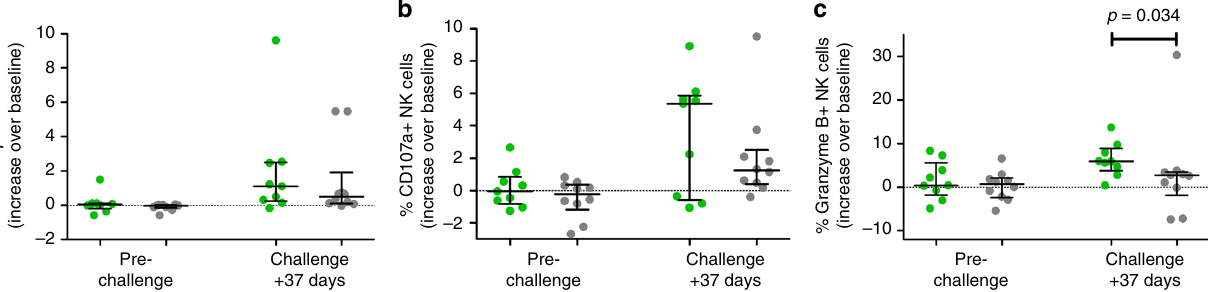
Fig. 4 BCG vaccination increases NK cell responses against P. falciparum . a Percentage of total NK cells staining positive for IFN- γ after 24 h of stimulation with Pf RBC before, and 37 days after malaria challenge infection as compared to baseline (pre-BCG vaccination time point), each dot represents an individual BCG vaccinated ( n = 9, green) or control volunteers ( n = 10, grey). b Percent NK cells staining positive for the degranulation marker CD107a. c Percent NK cells staining positive for granzyme B. Lines and error bars show median and interquartile range. p -values are the result of Mann – Whitney U - test. * p < 0.05. Stimulation was performed in duplo, with replicates combined for fl ow cytometry analysis